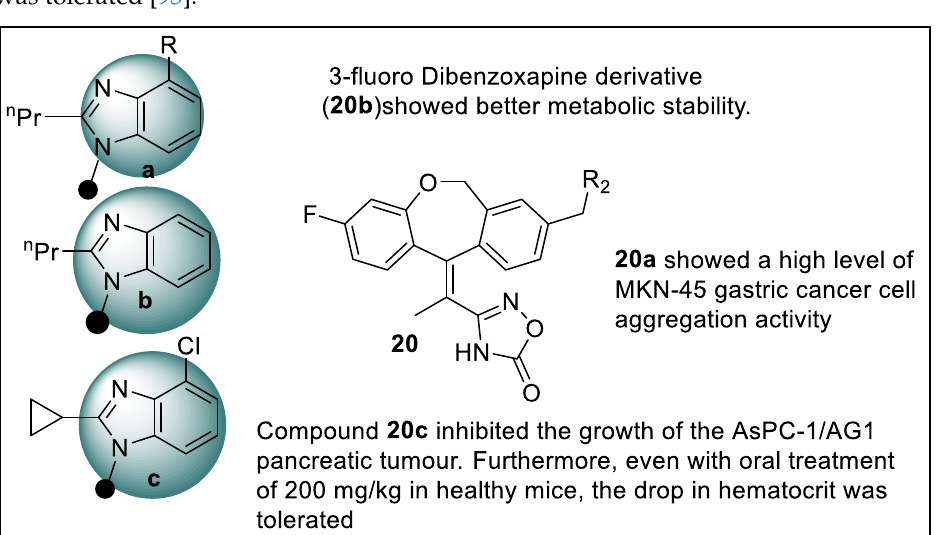
Figure 23. Structural activity relationship of Benzimidazole hybrids ( 20 ) as potent PPAR